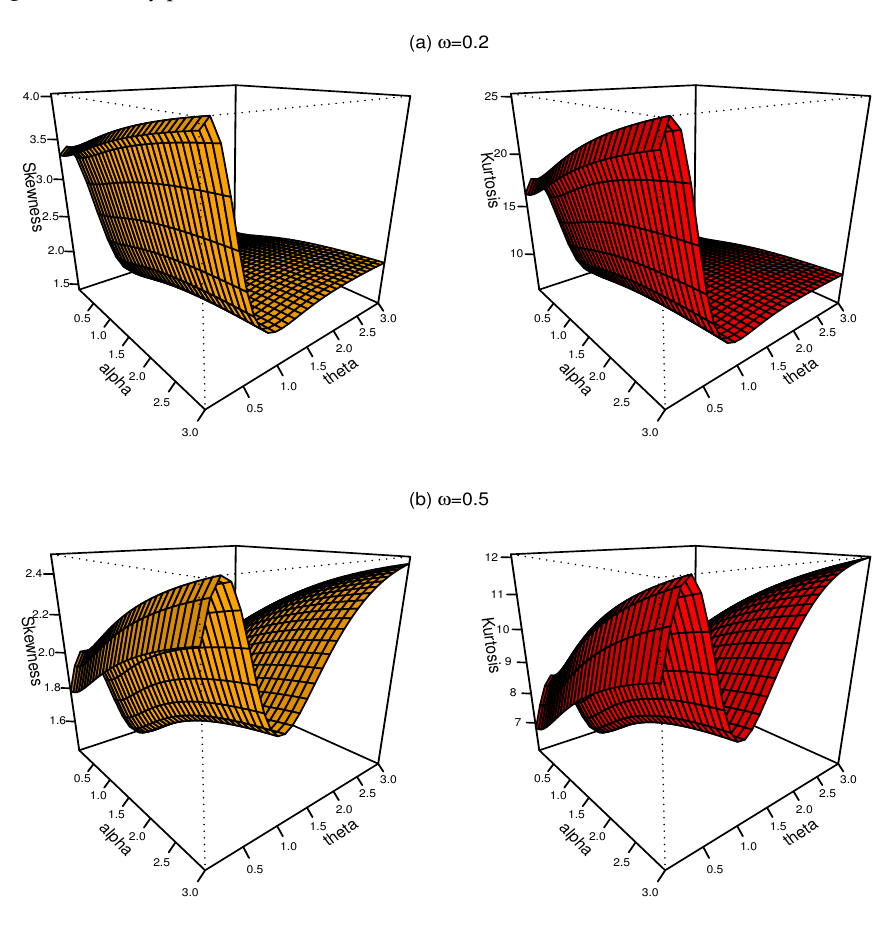
Figure 2. 3D plots of skewness and kurtosis of CWE distribution for two fixed values of ω